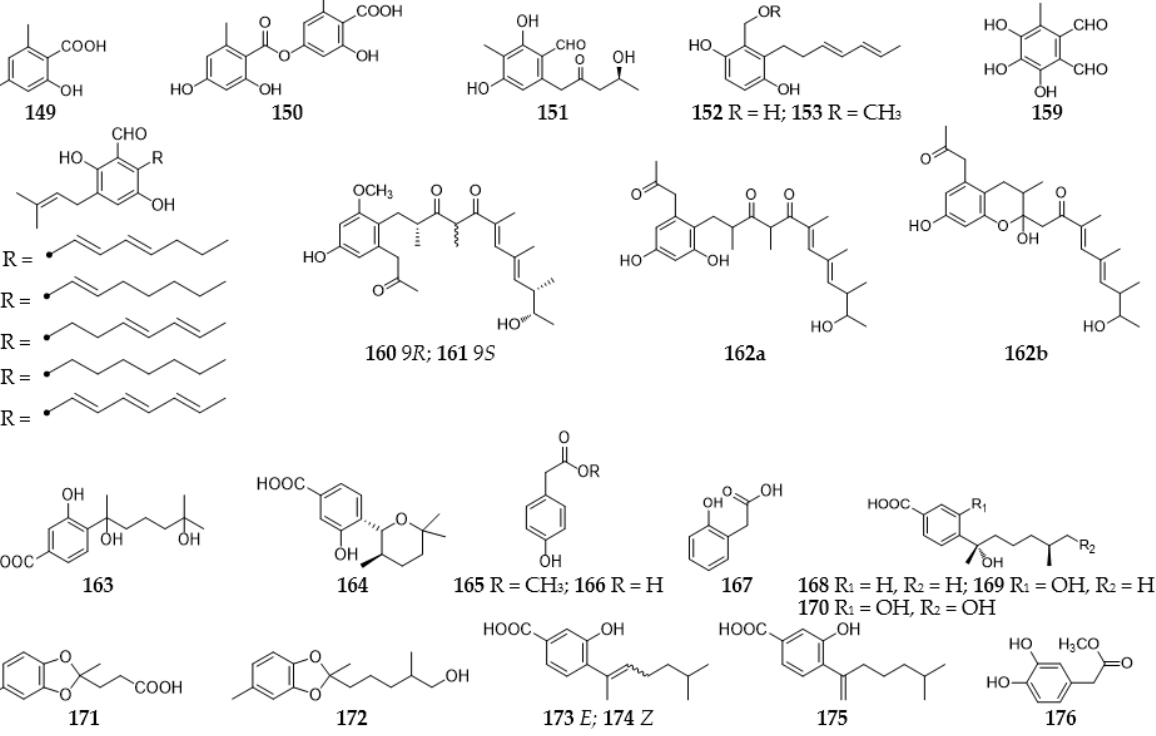
Figure 10. Aspergillus -derived phenolic compounds ( 149 – 176 ).